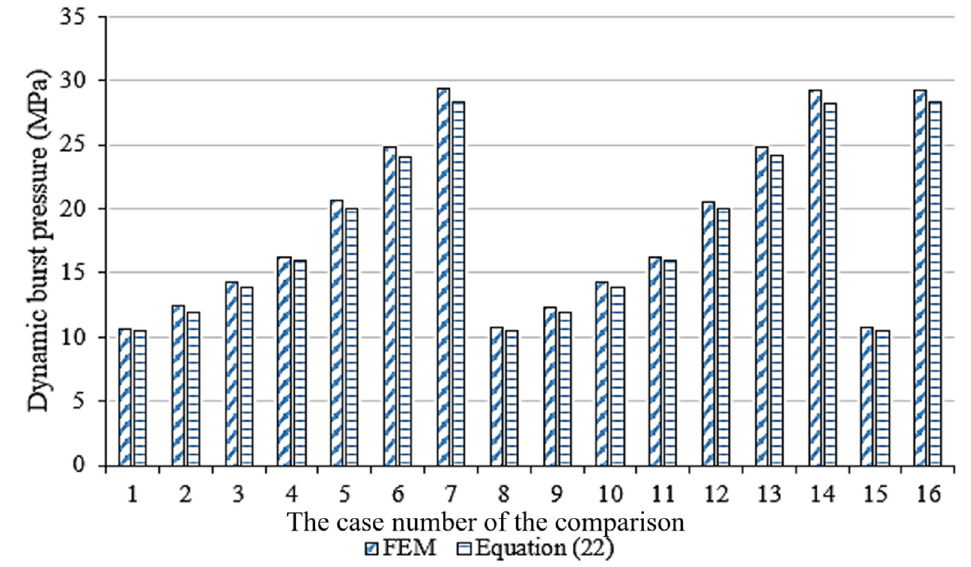
Figure 8. Comparisons between the FEM results and Equation (22), when t d = 390 ms.